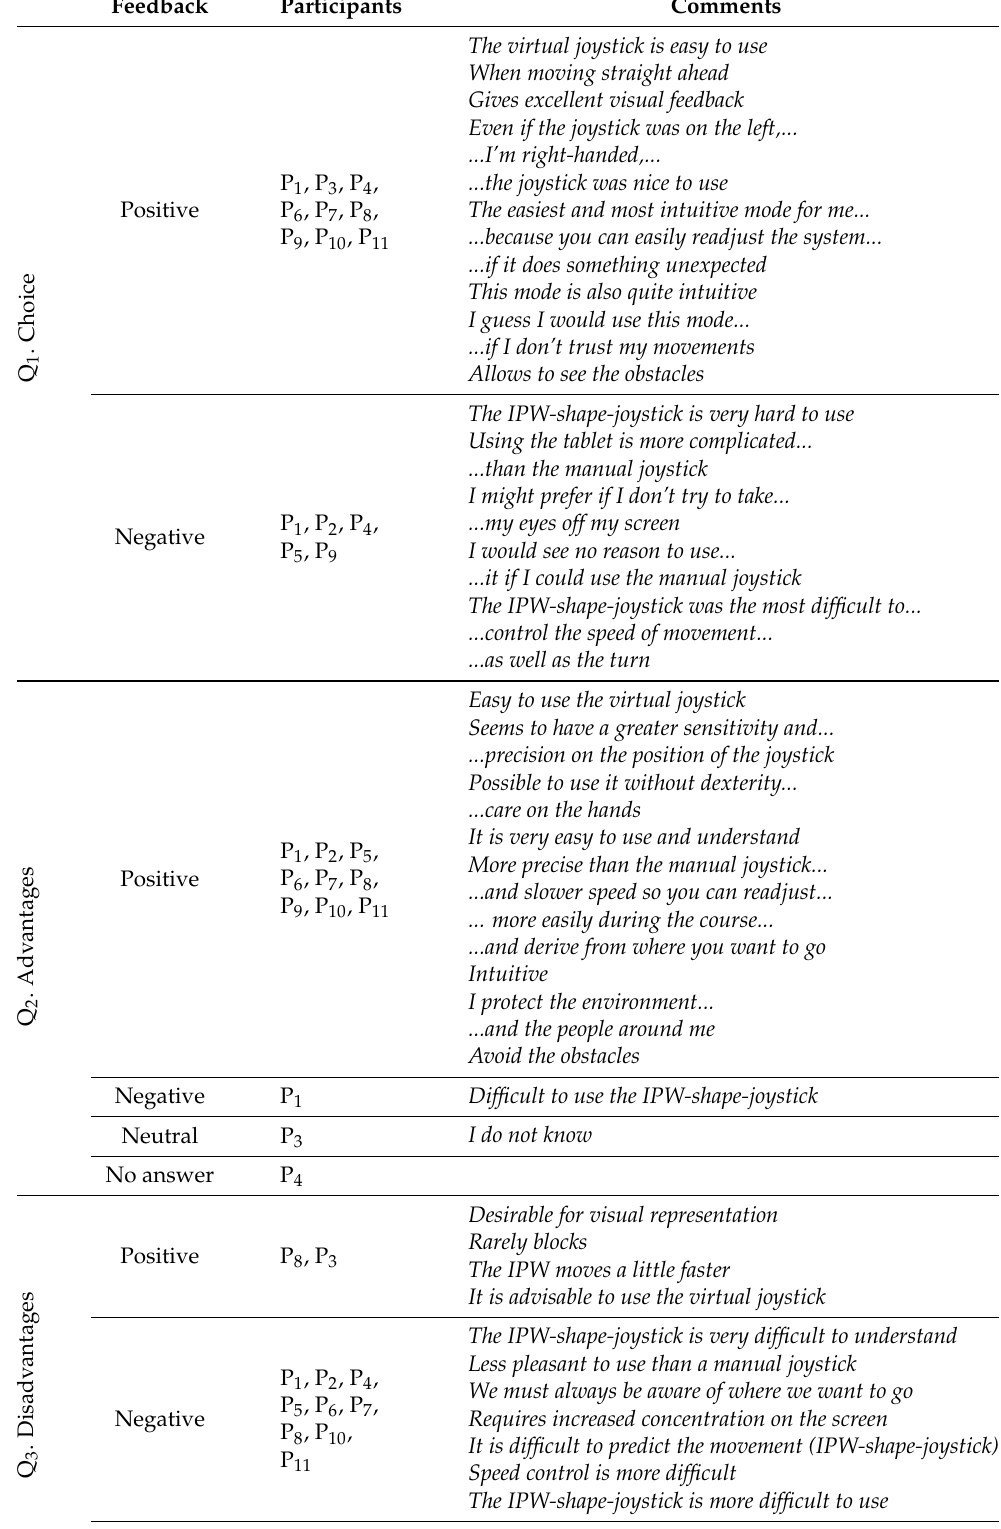
Table 4. Semi-autonomous